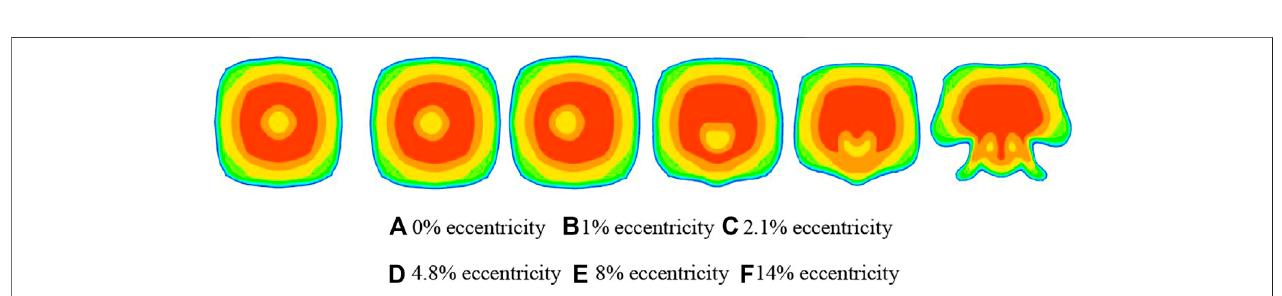
FIGURE 14 | Velocity cloud diagram of jet velocity greater than 20 m/s in y = 30 mm section under different eccentricity.